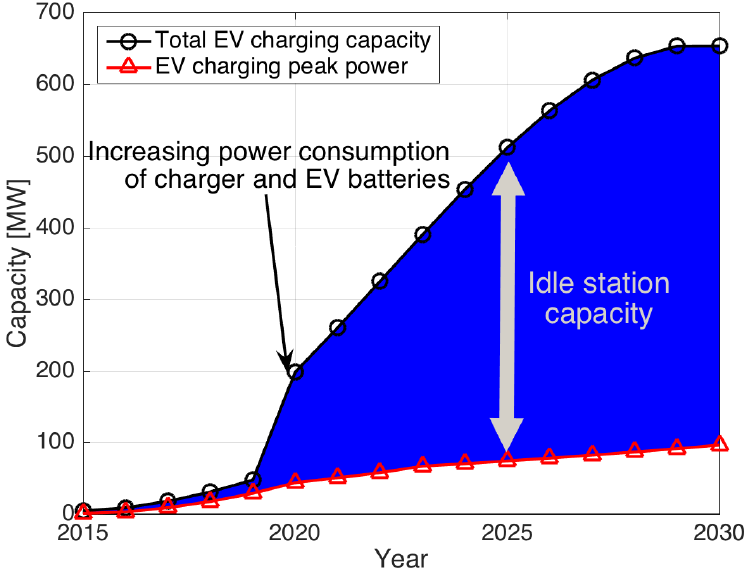
Figure 6. Idle station capacity estimation.